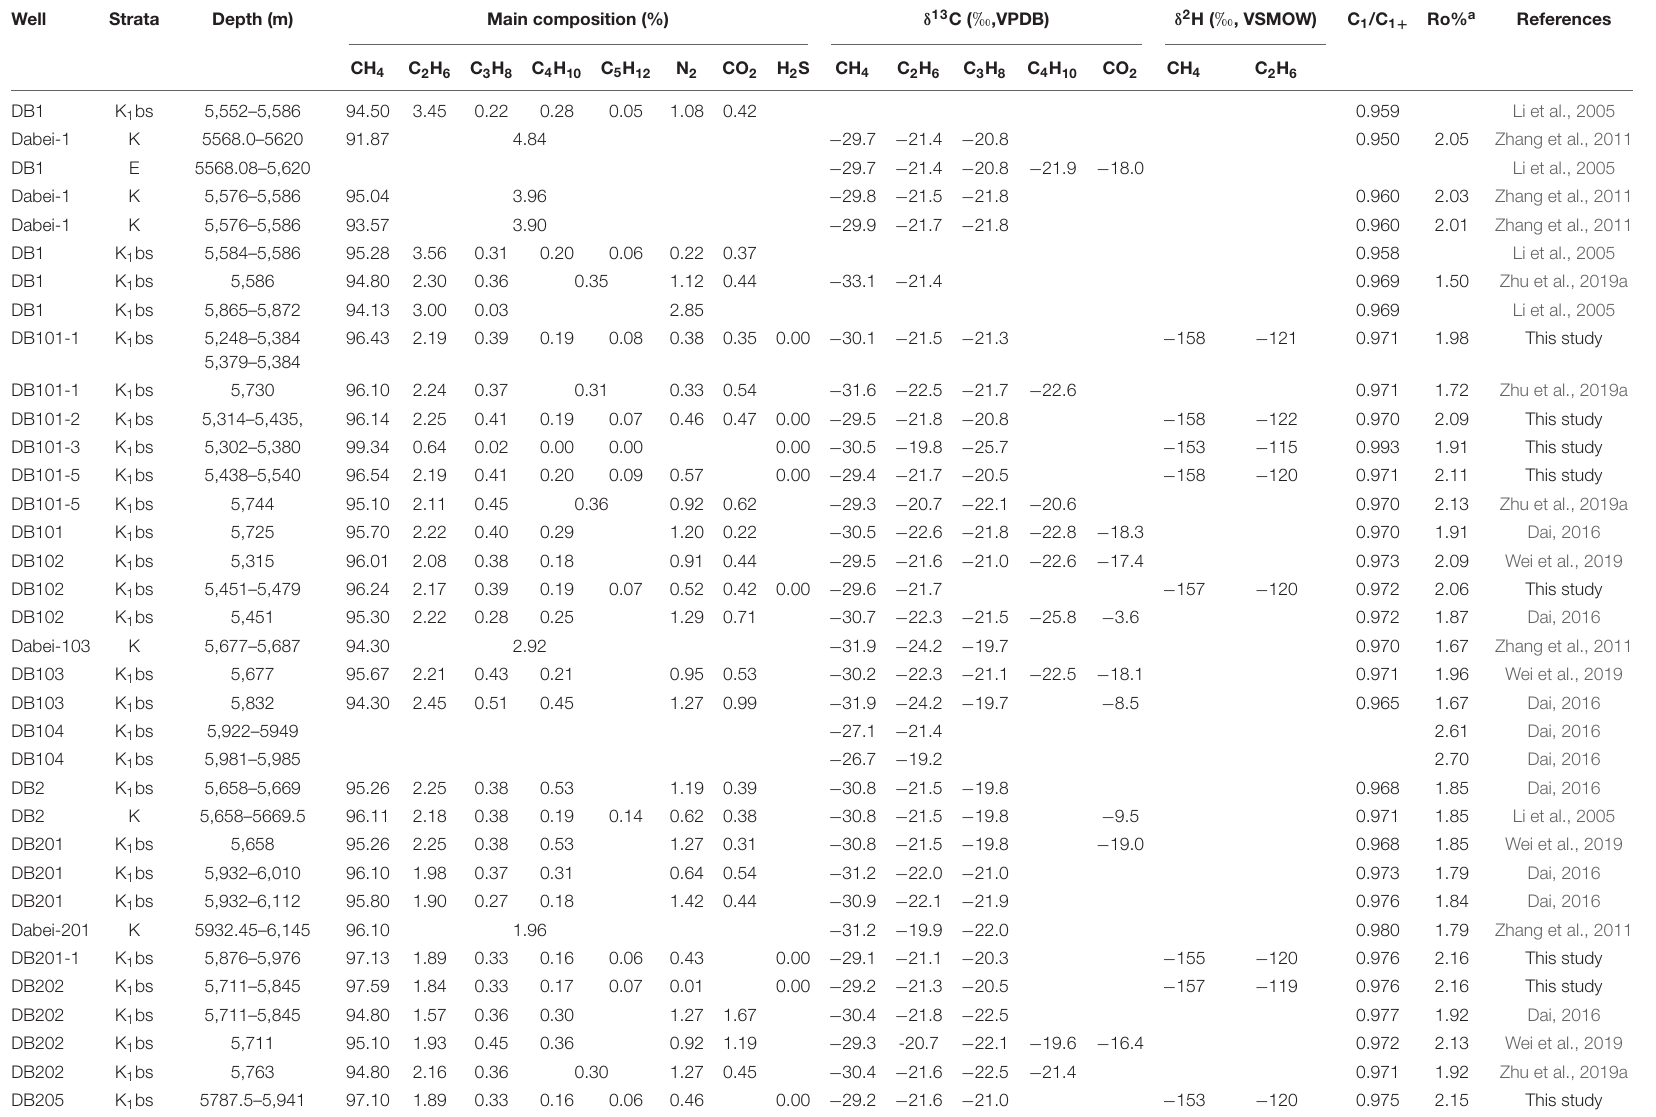
TABLE 1 | Molecular composition and stable carbon and hydrogen isotopic values of deep gas from Dabei gas field, Kuqa depression, Tarim basin.